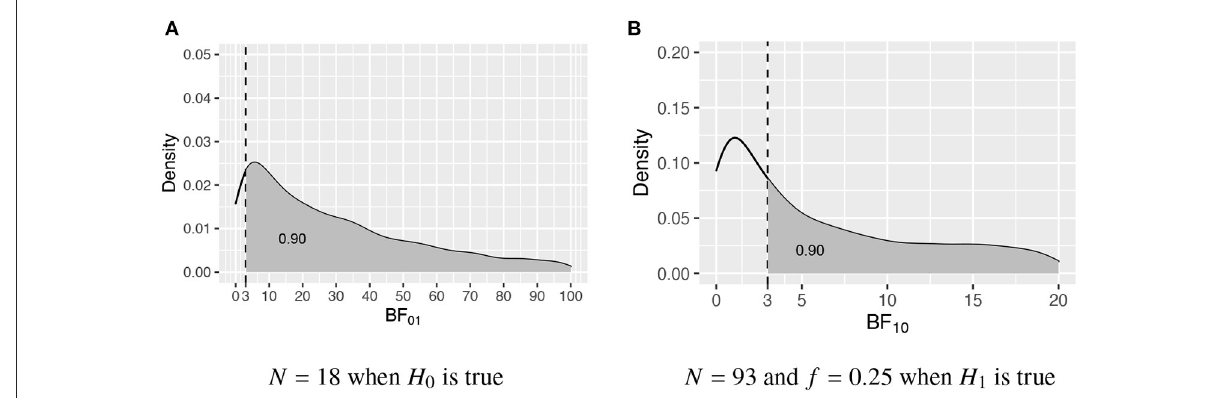
FIGURE1 The sampling distribution of BF 01 under H 0 and BF 10 under H 1 . The vertical dashed line represents BF thresh = 3, and the gray area denotes η , that is, the probability that the Bayes factor is larger than 3. (A) N = 18 when H 0 is true. (B) N = 93 and f = 0.25 when H 1 is true.